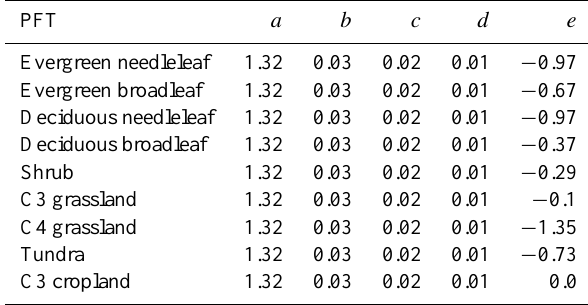
Table 2. Model coefficients used in mixed-effects model to predict g 1 from two long-term average (1960–1990) bioclimatic variables: temperature and a moisture index representing an indirect estimate of plant water